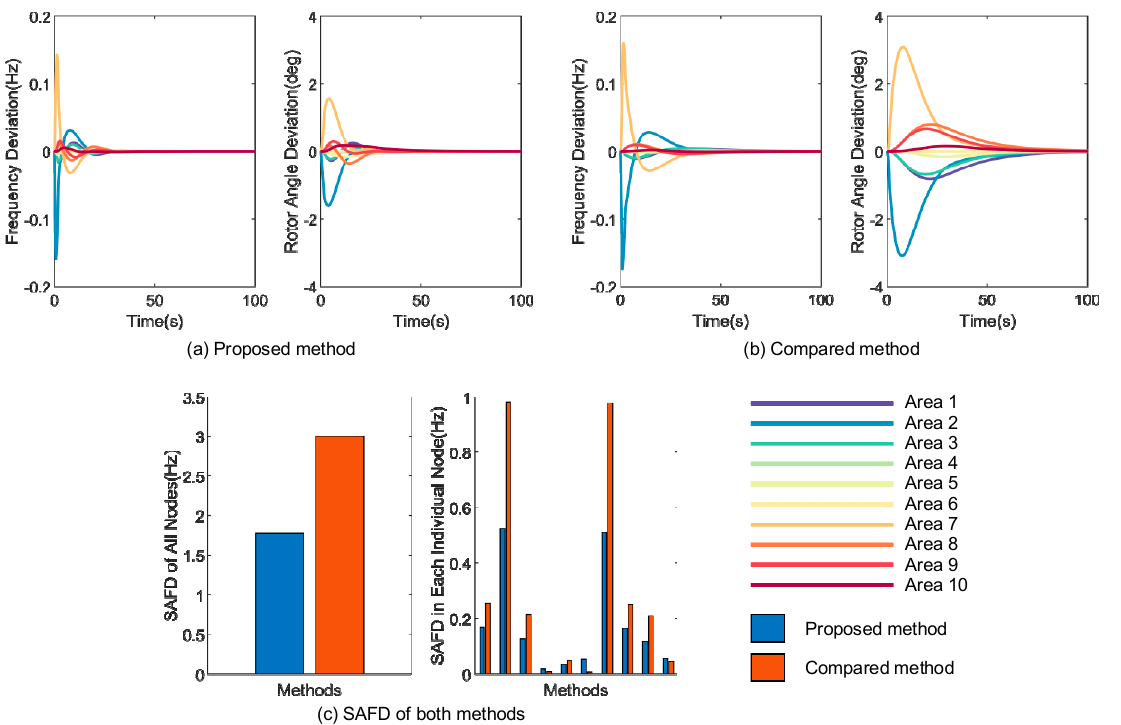
Figure 10. Frequency deviation, rotor angle deviation and sum of absolute frequency deviation (SAFD) of both methods in the frequency event D.